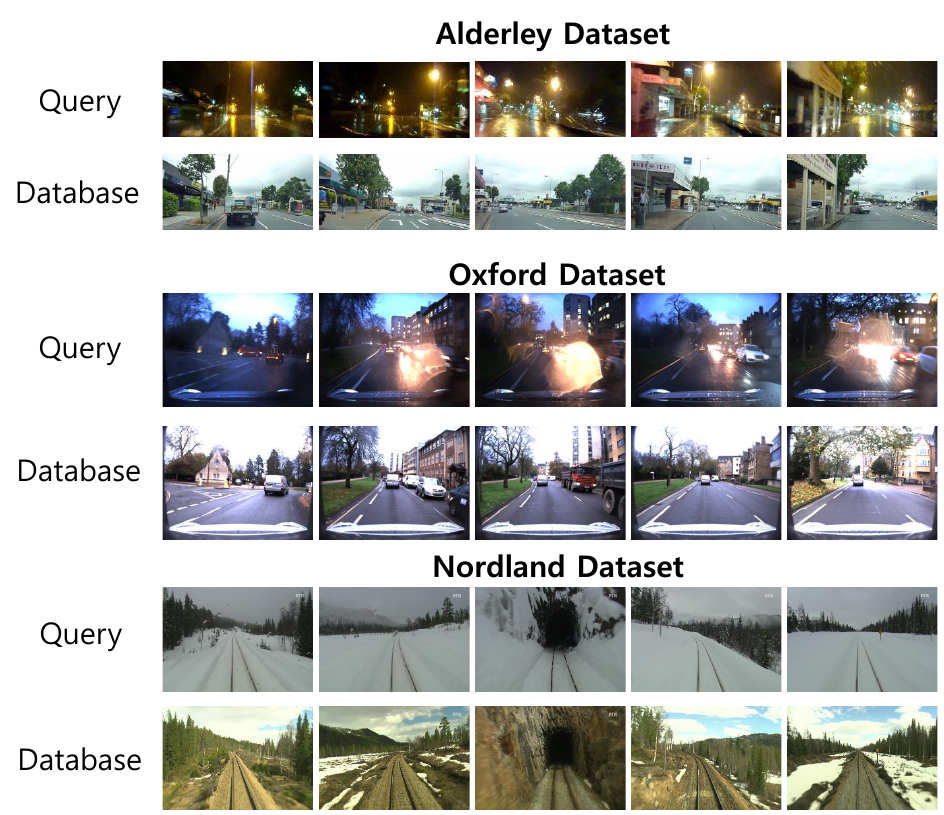
Figure 4. Sample image sequence taken from each of the 3 datasets: Alderley (day-to-night), Oxford (sunny-to-rainy), and Nordland